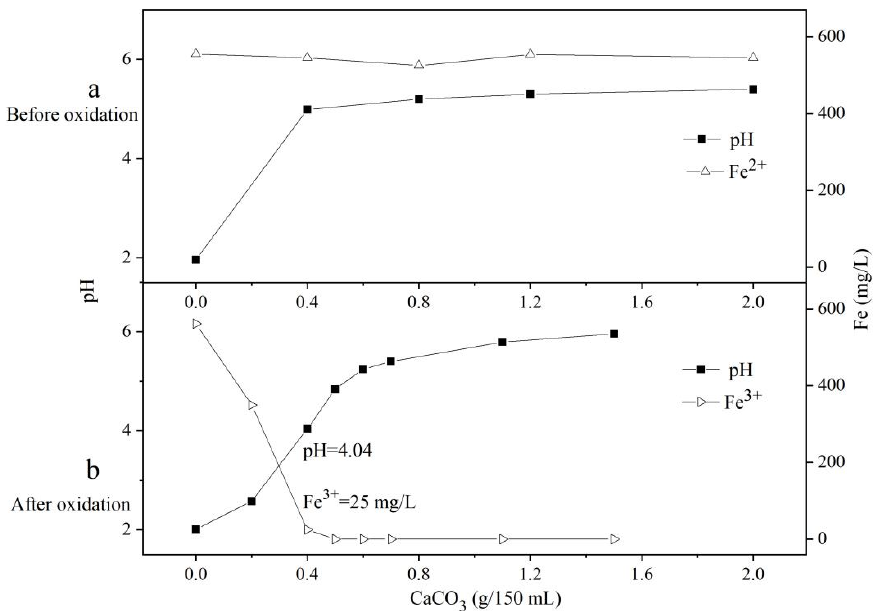
Figure 9. The effect of the CaCO 3 amount on the pH and soluble Fe of the Fe 2+ -rich simulated acid mine drainage before ( a ) and after ( b ) oxidation.